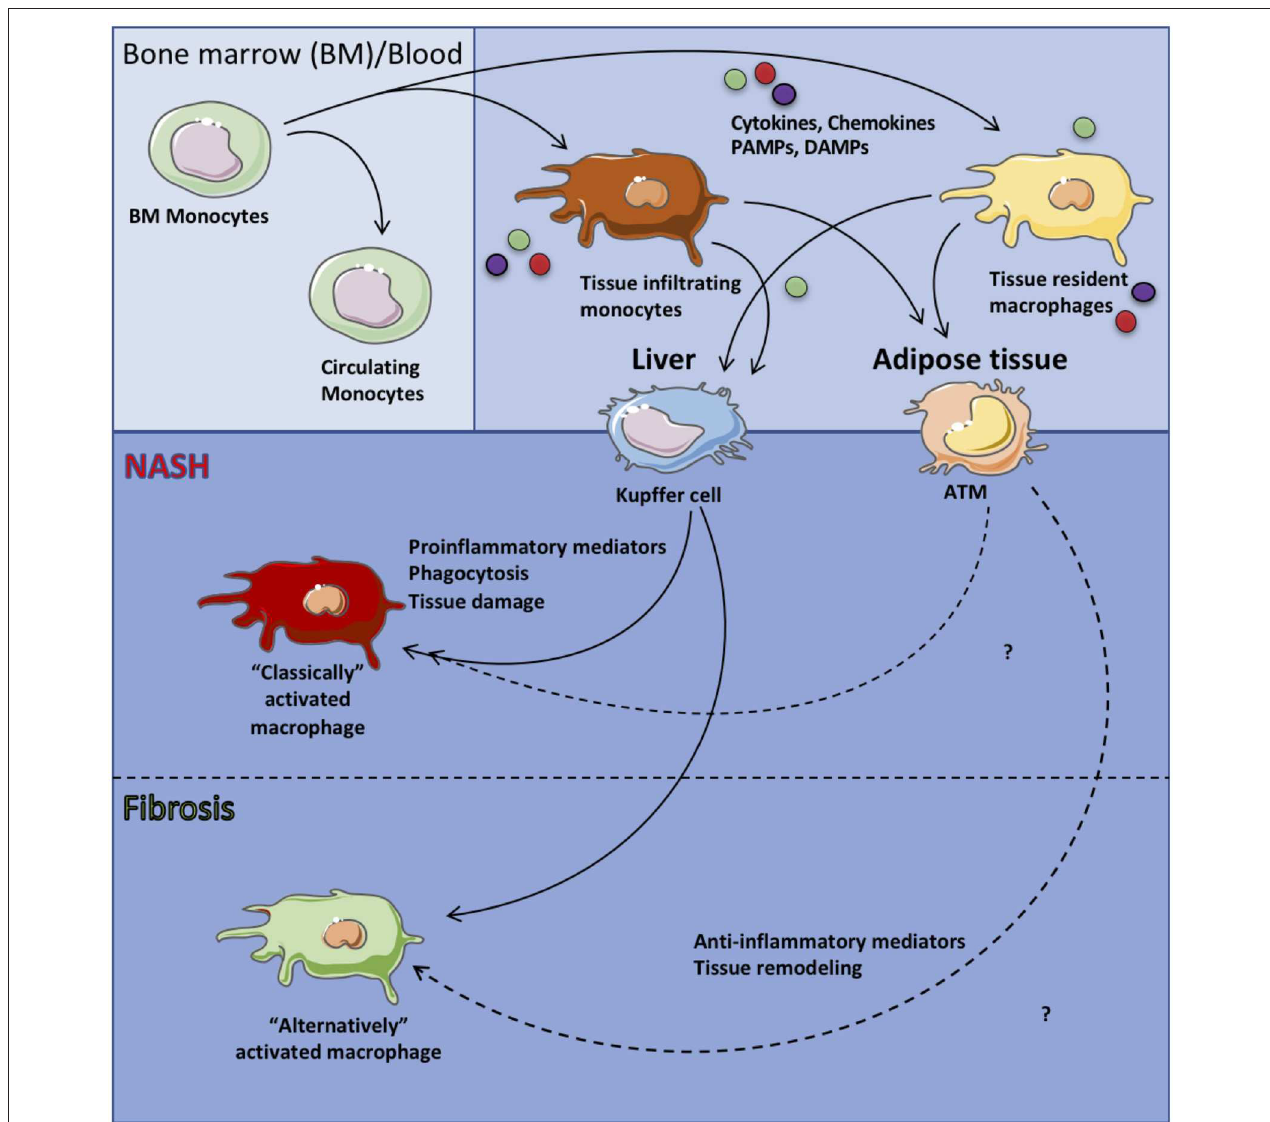
FIGURE 1 | Macrophage subsets in health and disease. Circulating monocytes originating from the bone marrow are recruited to specific tissues and differentiate into tissue resident macrophages. In the context of systemic inflammation, circulating monocytes as well as tissue resident macrophages are activated by sensing of proinflammatory mediators (i.e., IL-6, TNF, IL-1 β ), chemokines and ROS or anti-inflammatory mediators (i.e., IL-10) leading to “classically” or “alternatively” activated tissue macrophages, respectively which then contribute to tissue